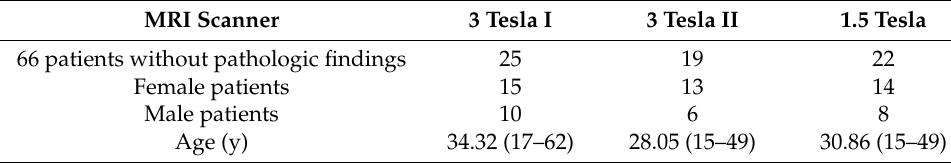
Table 1. Details of the patient